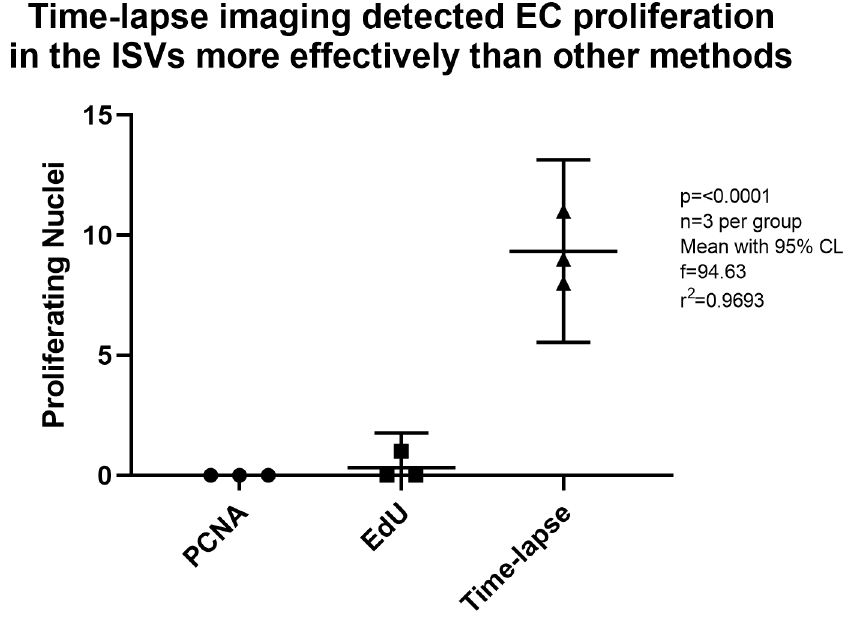
Figure 5. A comparison of detection of EC proliferation by PCNA immunolabelling, EdUcell labelling and time- lapse imaging of fluorescently labelled EC nuclei. Endothelial cell proliferation was studied at 30 hpf in PCNA treated embryos, 30 to 31 hpf in EdU treated embryos, and 29 – 45 hpf in time-lapse imaged embryos. Time-lapse imaging detected EC proliferation more effectively than other methods. Statistics were derived from analysis by ordinary one-way